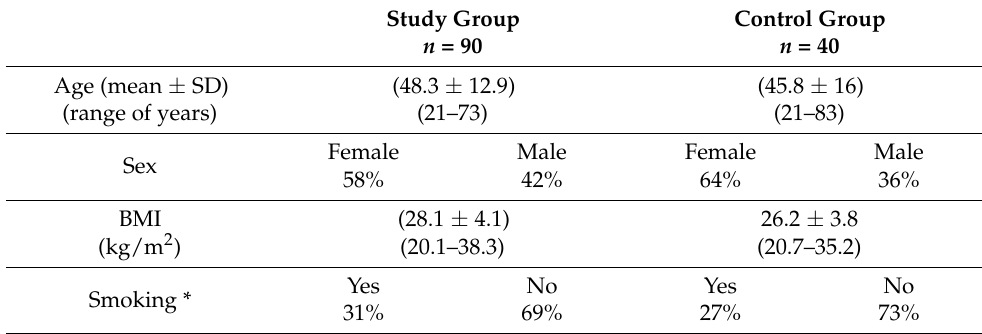
Table 1. Characteristics of patients and the control